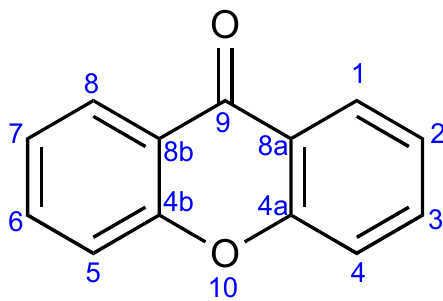
Figure 1. General structure of xanthone.